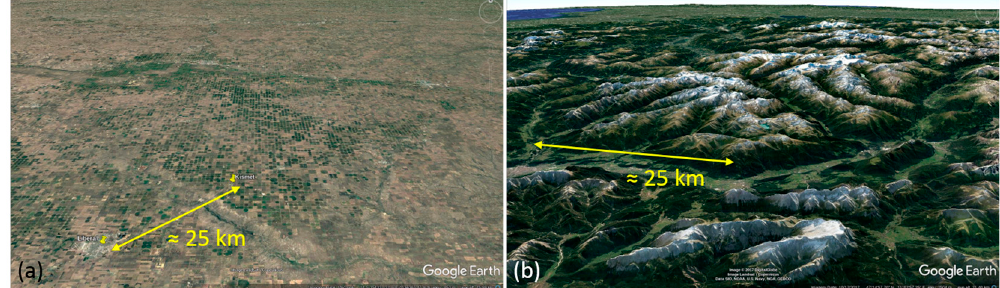
Figure 7. ( a ) View of the Kansas 1969 experimental site, looking north, where the benchmark ‘Kansas data set’ was obtained, from which many boundary layer parameterizations stem. The measurements were taken about 50 km northeast of Liberal, Kansas [157], near Kismet; ( b ) View of the Alps, looking south, with Mount Zugspitze in the foreground and the Inn Valley running east to west.